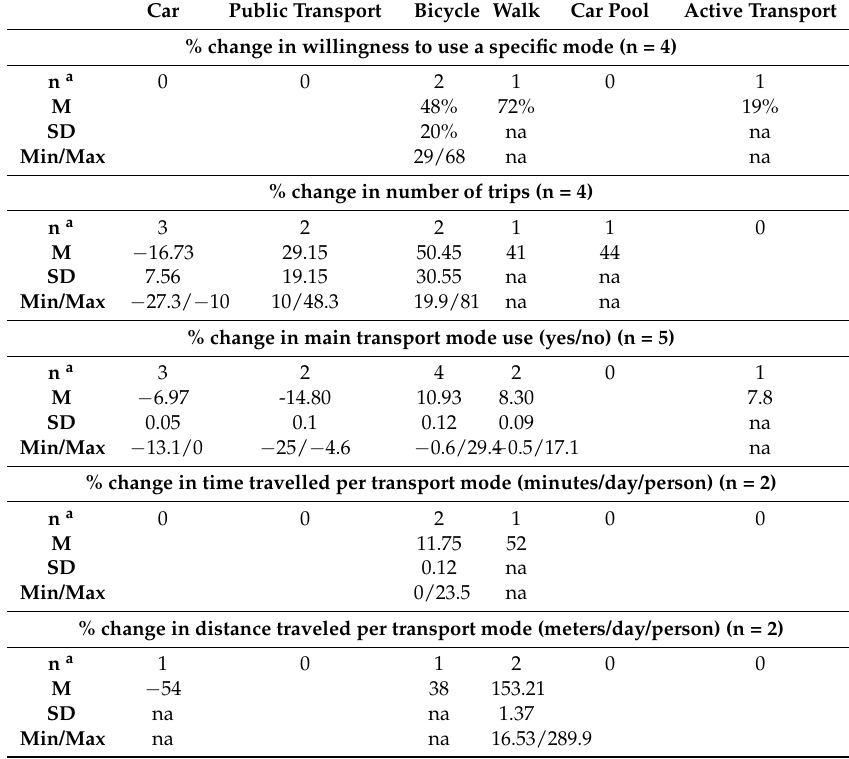
Table 5. A summary of the general outcome measures post-intervention in the included papers. Car Public Transport Bicycle Walk Car Pool Active Transport